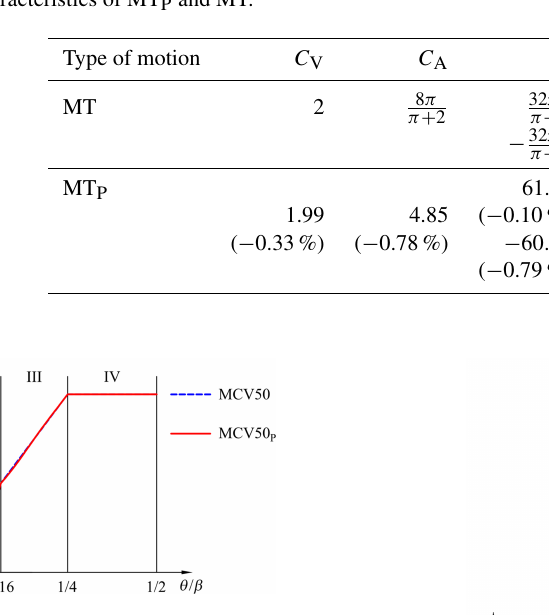
Figure 10. Variation in phase angle function in Example 4.